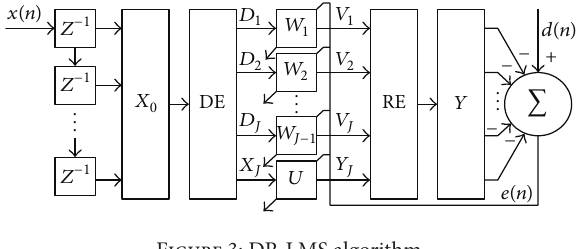
Figure 3: DR-LMS